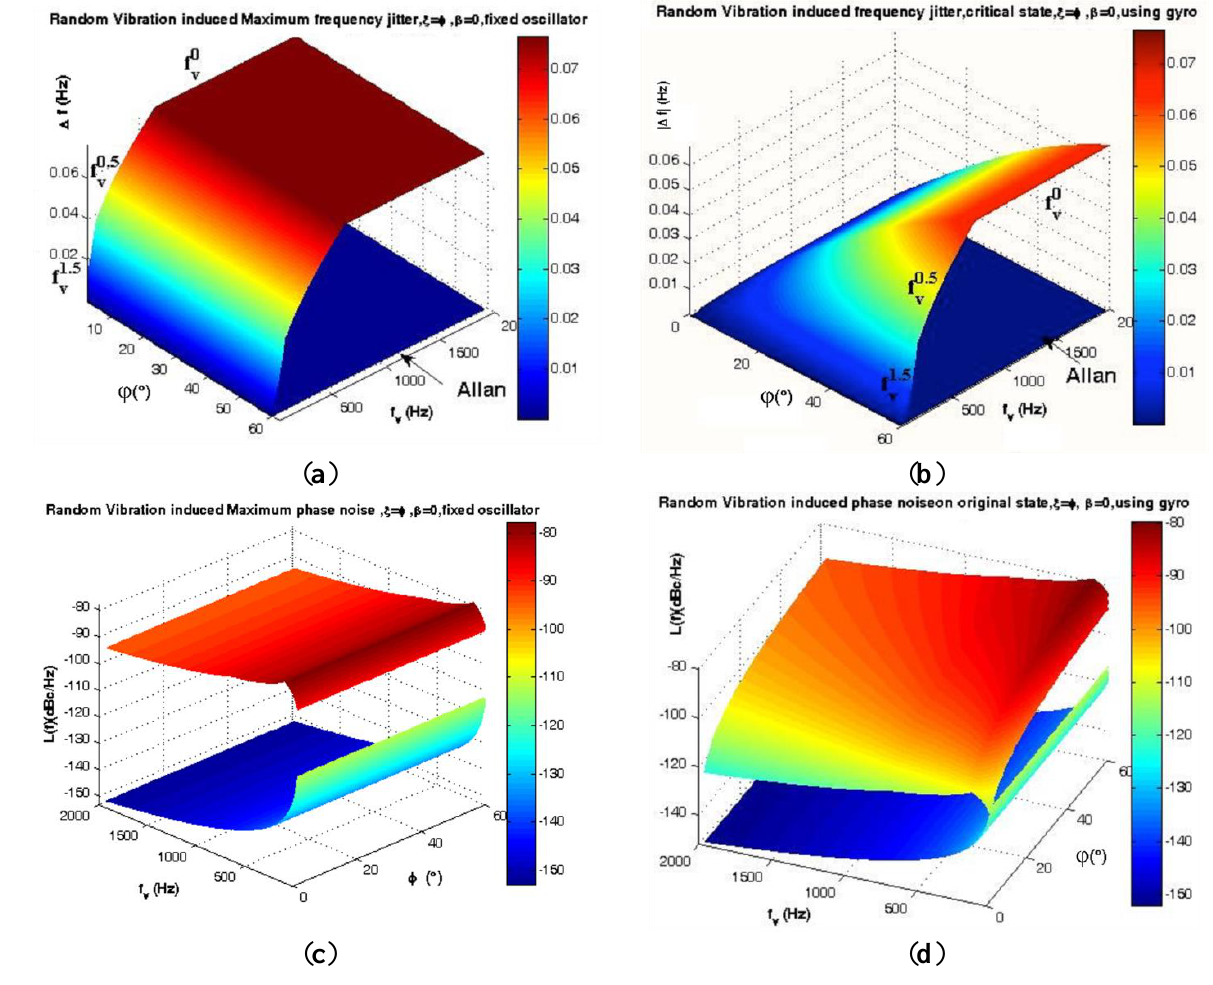
Figure 25. Analysis of random vibration in frequency domain for ξ = φ, β = 0. ( a ) Frequency jitter of fixed oscillator; ( b ) Frequency jitter of gyroscopic mounting; ( c ) Phase noise of fixed oscillator; ( d ) Phase noise of gyroscopic